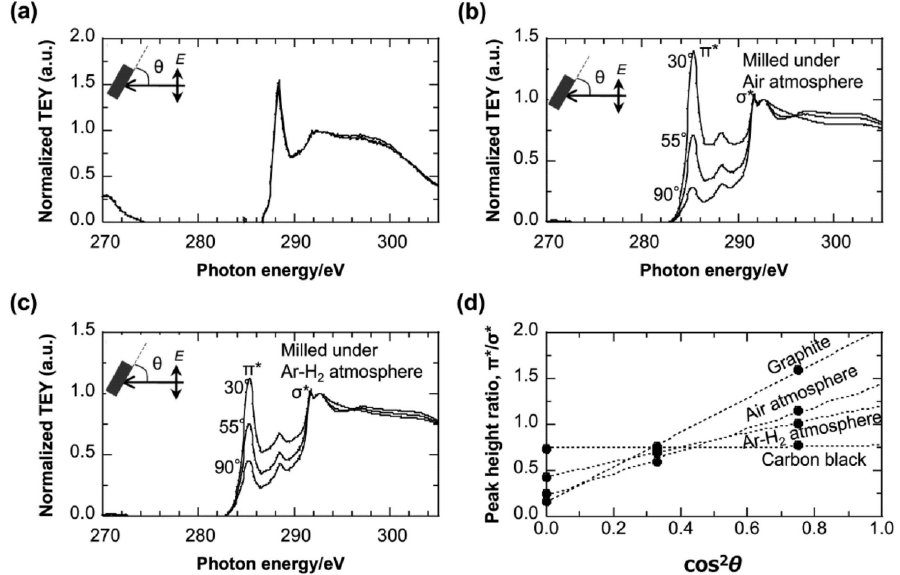
Fig. 10 Incident-angle dependent C K-edge X-ray adsorption near-edge structure (XANES) of iron powders milled (a) without graphite, and with graphite (b) in air and (c) in an Ar–H 2 gas, and (d) variation in the peak height ratio of π */ σ * among four specimens; graphite, two iron powders milled in air and in an Ar–H 2 gas and carbon black [142]. Reproduced with permission from Ref.